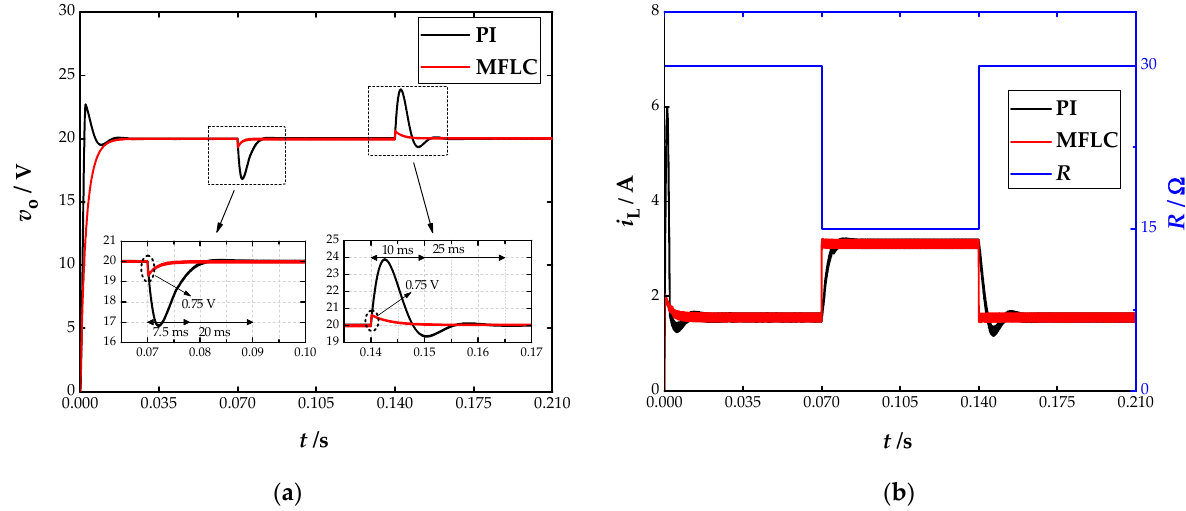
Figure 6. The response of the buck-boost converter when the load resistance R changes suddenly at 0.07 and 0.14 s, respectively. ( a ) Response curve of the output voltage v o ; ( b ) Response curve of the input current i L .